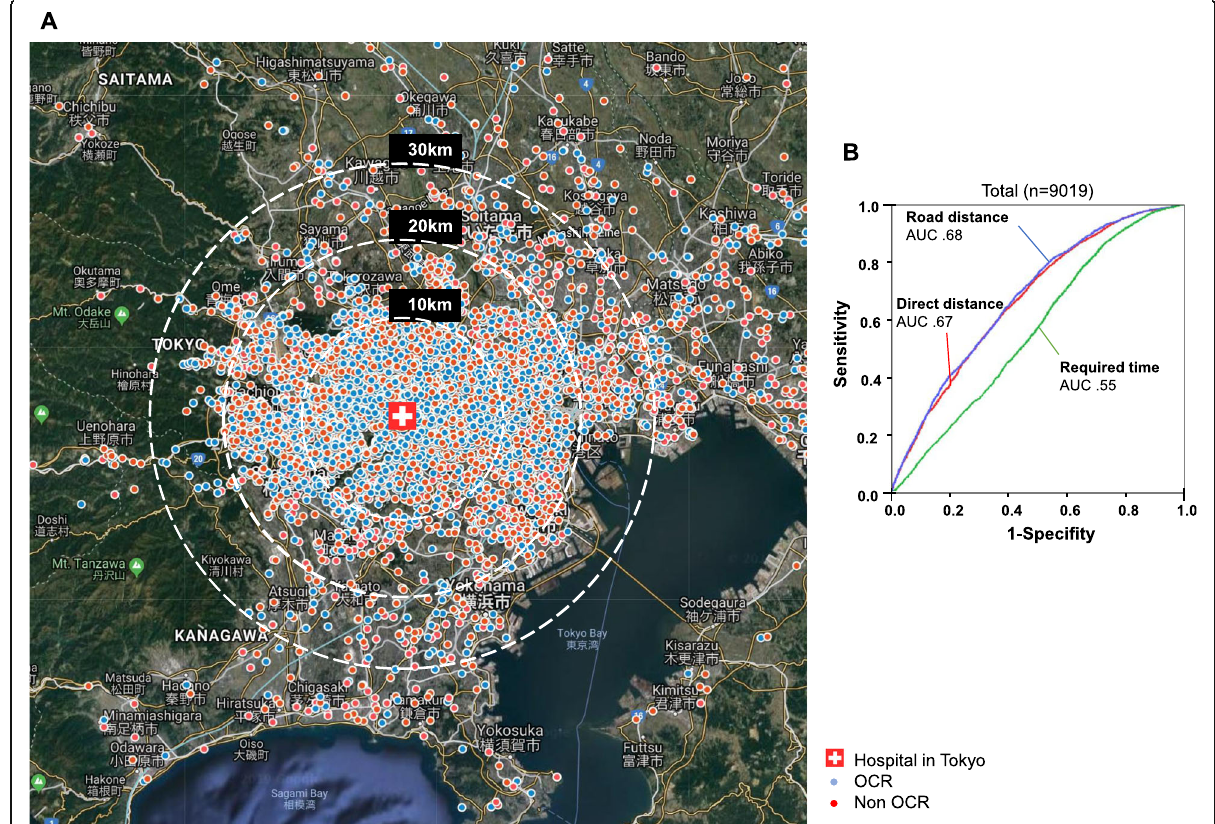
Fig. 2 Patients ’ home address and participation in OCR ( a ) and ROC curves for predicting the participation in OCR ( b ). A Map showing the home addresses of patients. The mark of the hospital depicts the location of our hospital in Fuchu City in Tokyo. Colored dots indicate the location of home addresses of patients (red: only in-hospital cardiac rehabilitation (non-participation group), blue: participation in outpatient cardiac rehabilitation). b ROC curves of road distance, direct distance, and required time from home to hospital for predicting the participation in OCR. OCR, outpatient cardiac rehabilitation; PCI, percutaneous coronary intervention; CABG, coronary artery bypass grafting; CHF, congestive heart failure; ROC, receiver operating